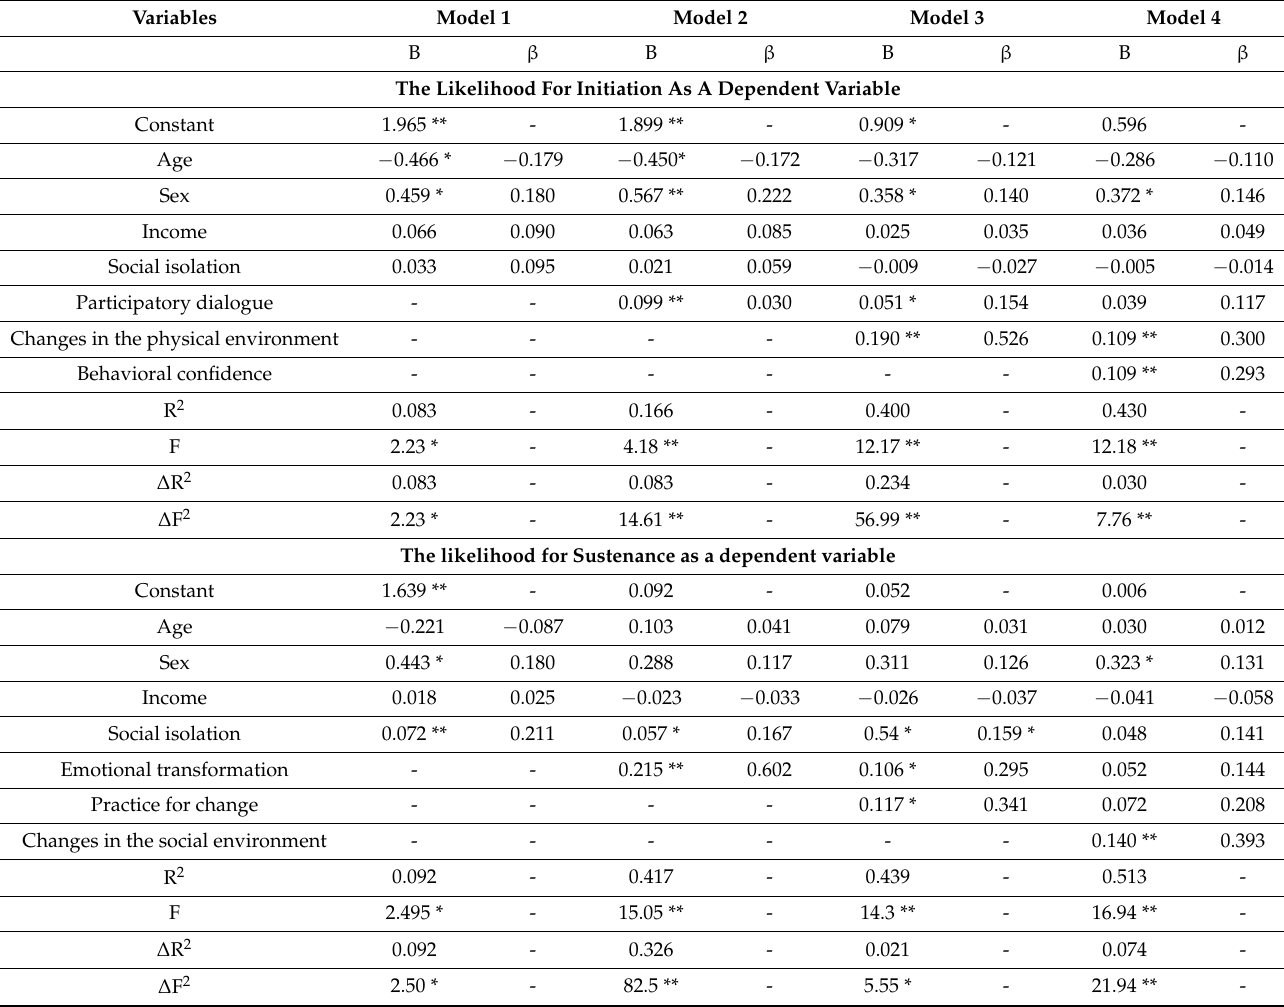
Table 5. Predicting likelihood for initiation and sustenance of technology non-users ( n = 155) through HRM.